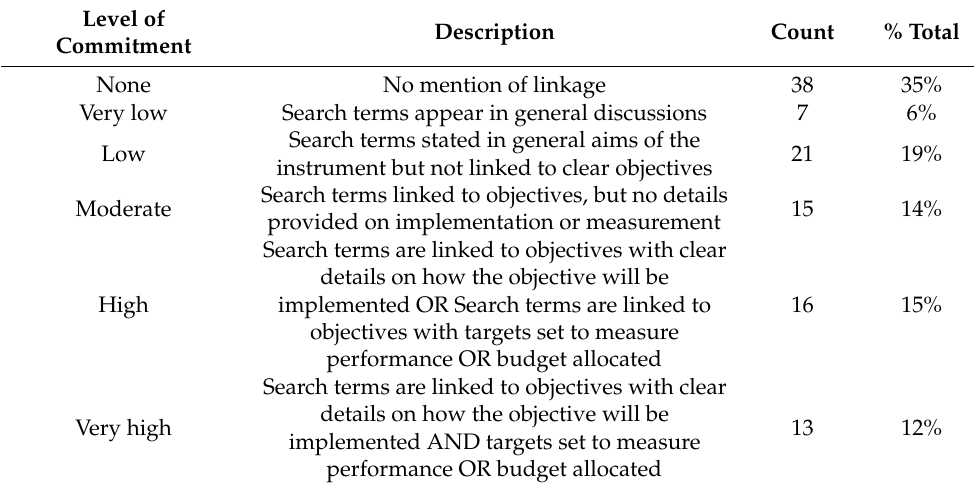
Table 6. Summary of the level of commitment to linking aquatic food and FNS.